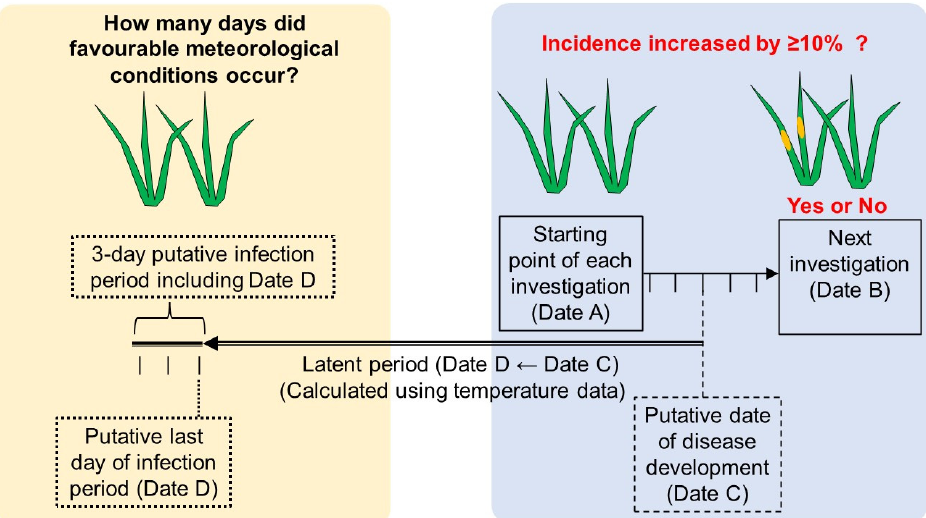
Figure 4. Flow chart for evaluating the relationship between meteorological conditions during the 3-day putative infection period and the probability of onion downy mildew disease development.